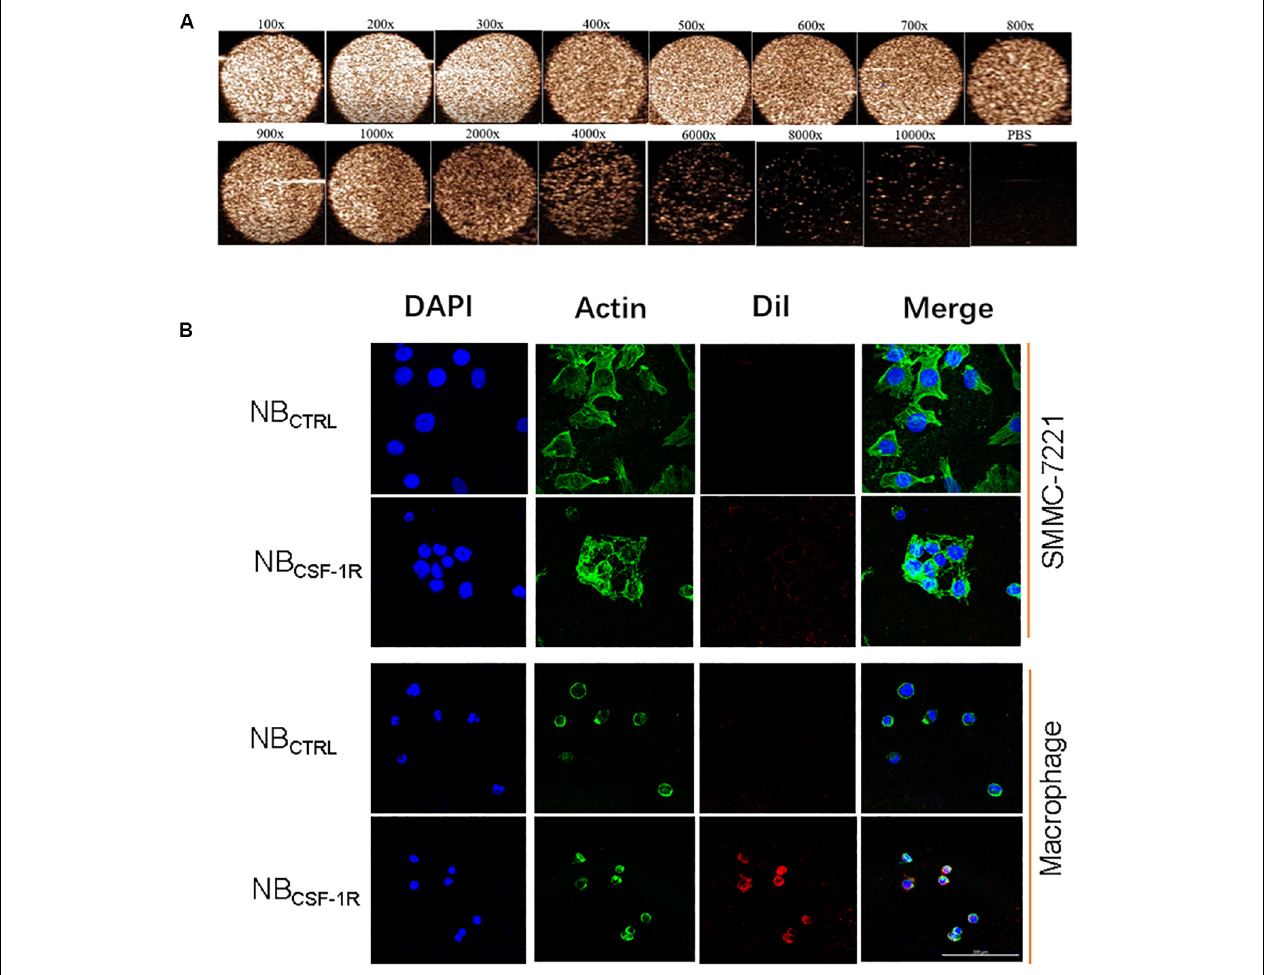
FIGURE 6 | (A) In vitro ultrasound images of various concentrations of NB CSF − 1R dilute for different times, imaging was still viable even when diluted 2000 times. Ultrasound frequency, 20 MHz. (B) In vitro , the same quantity of NB CSF − 1R and NB CTRL were added to SMMC-7721 and macrophages and then observed using confocal laser scanning microscopy (CLSM). There were few NB CTRL adhered to SMMC-7721 and macrophages, and also few NB CTRL bounded to macrophages. There were a lot NB CSF − 1R bounded to macrophages, and showed the specificity of targeting. With a scale bar of 100 µ m.